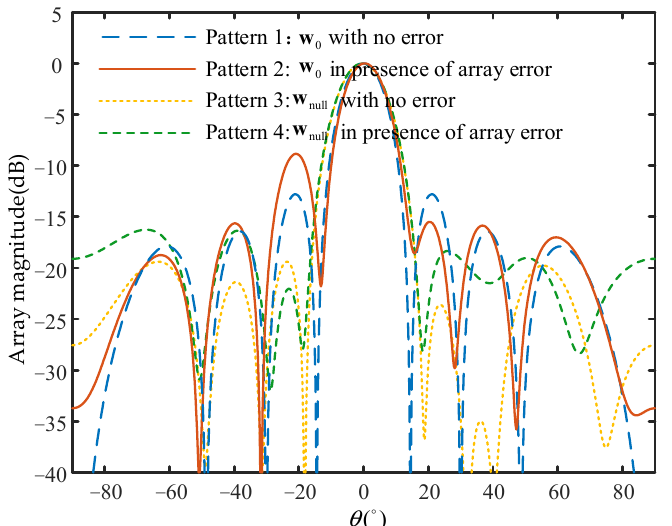
Figure 2. Normalized array beampatterns of 8-element uniformly spaced linear array with and without array errors, where f = 9 GHz and d = 0.5 λ .